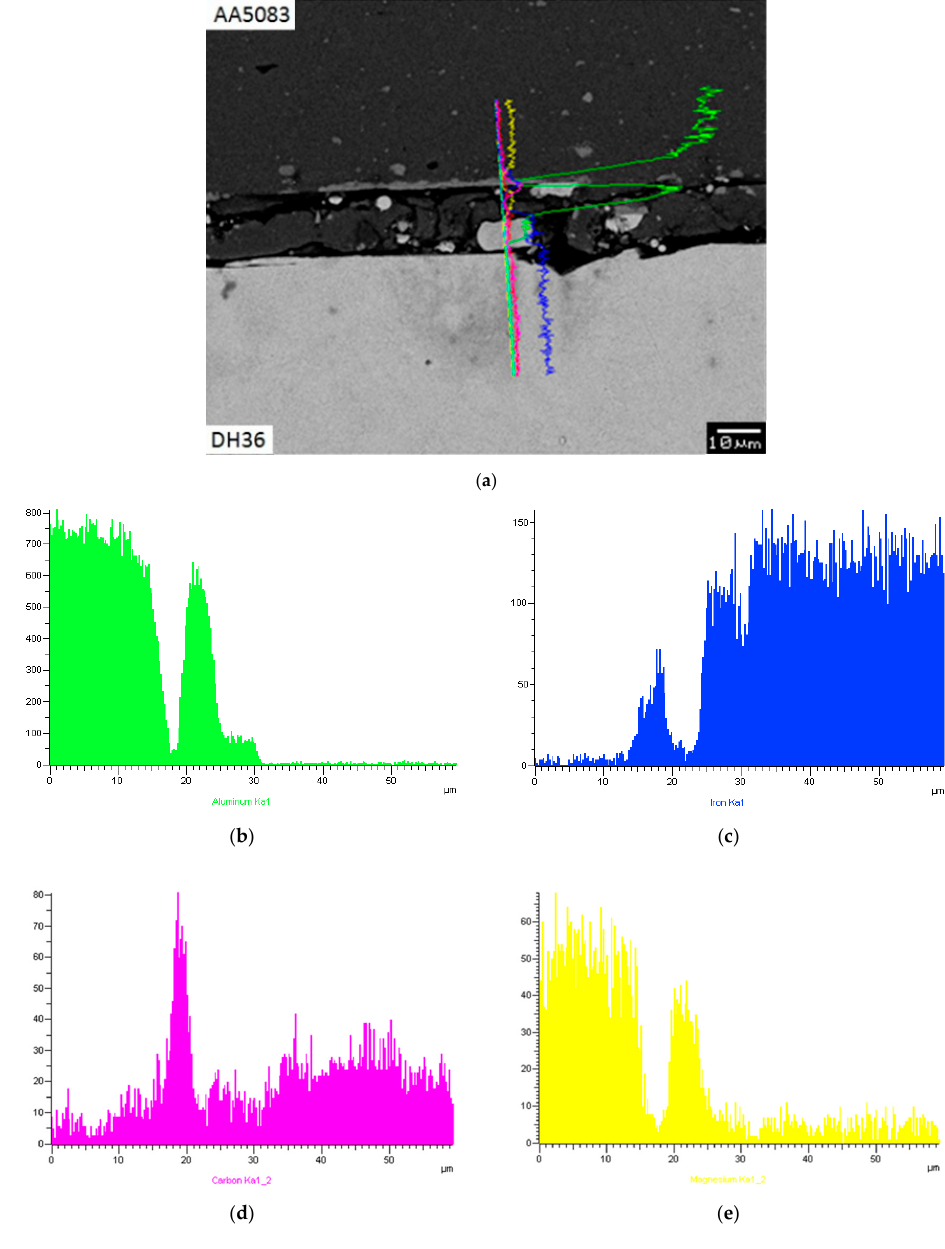
Figure 18. Graphs of line scanning in electron dispersive X-ray spectroscopy (EDS) analysis: ( a ) position of line scanning, ( b ) Al distribution, ( c ) Fe distribution, ( d ) C distribution and ( e ) Mg distribution.